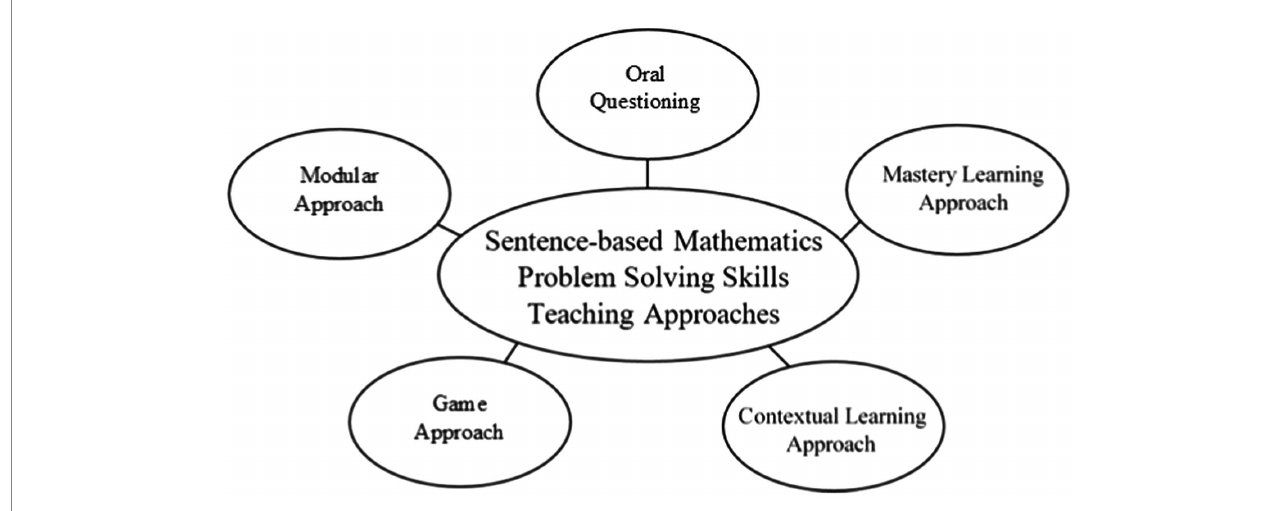
FIGURE 3 Sentence-based mathematics problem-solving teaching